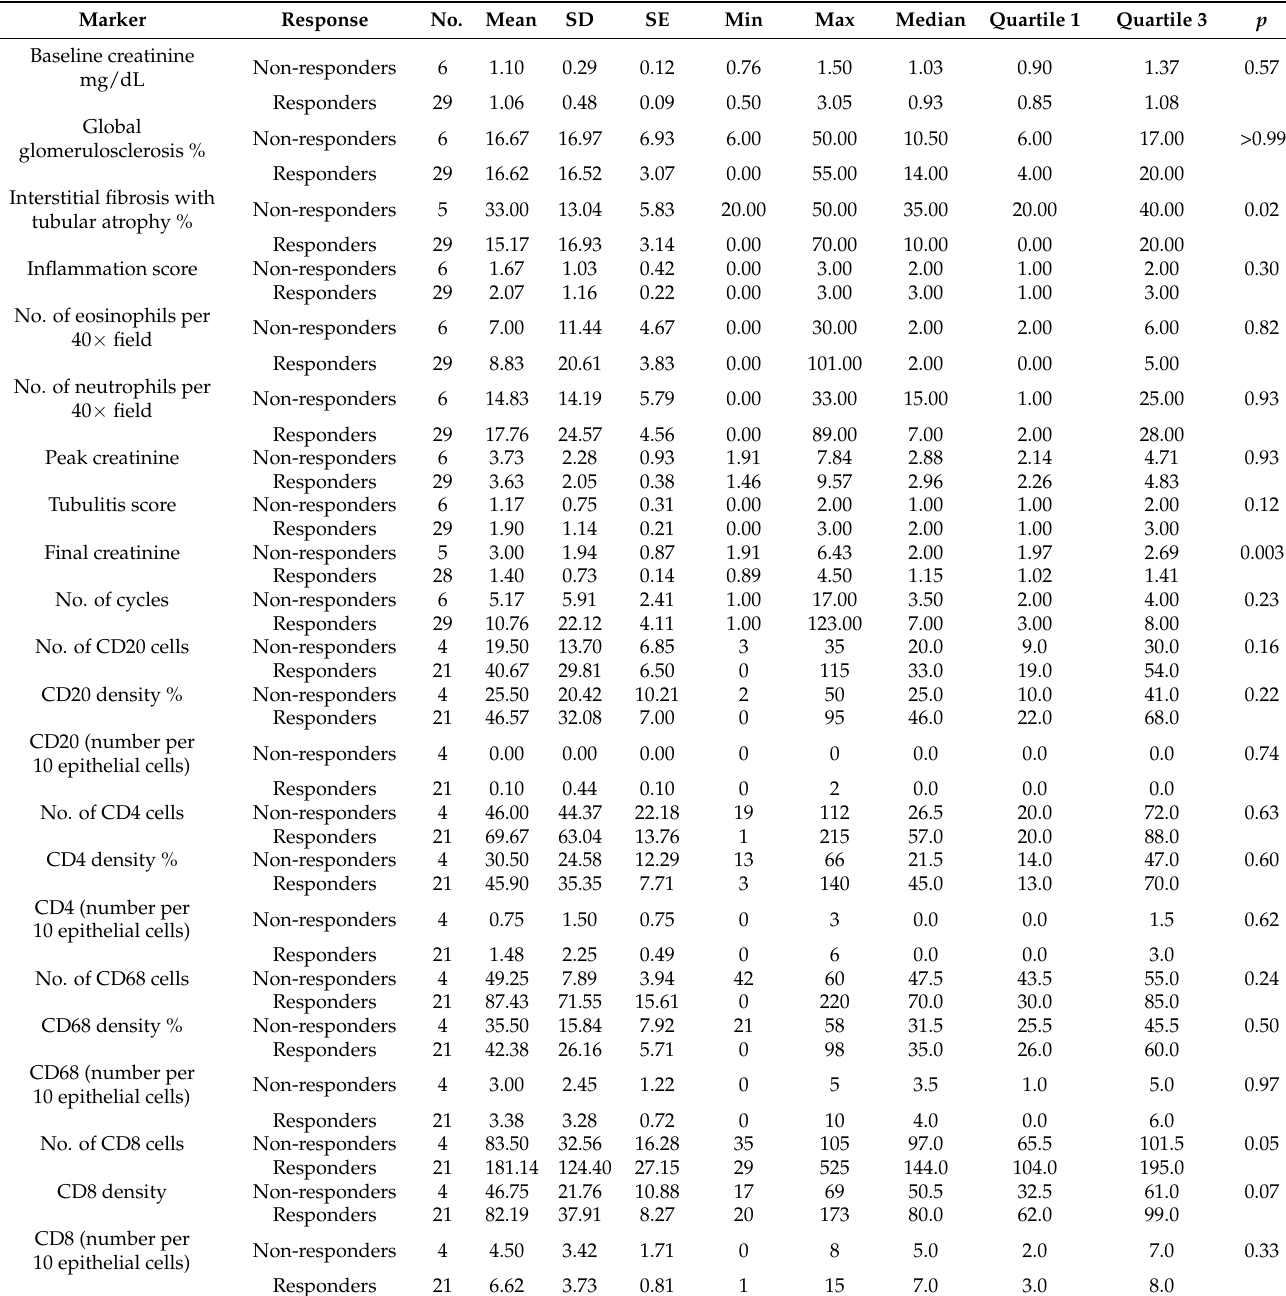
Table 3. Association of pathologic markers with response (n = 26) or non-response (n = 9) to treatment for immune checkpoint inhibitor–induced acute interstitial nephritis at 3 months after initiation of